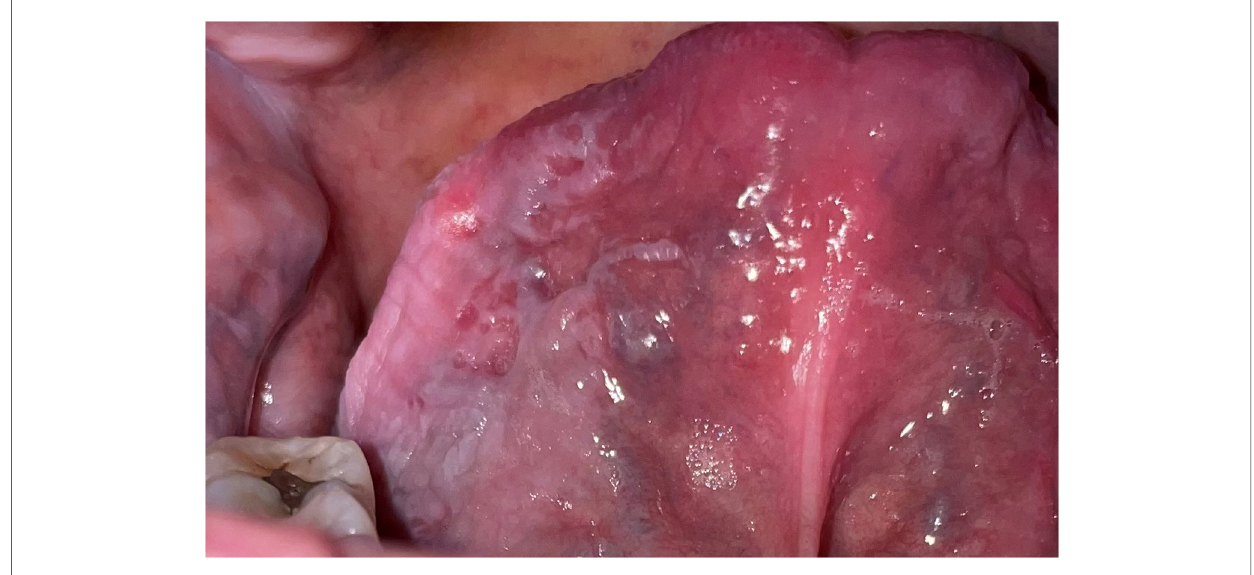
FIGURE 1 Extensive homogeneous leukoplakia involving the ventral tongue. Both its size and site are clinical indicators that this lesion is of clinical signi fi cance and has a greater potential to become malignant than a smaller leukoplakia in a different intra-oral site. It needs a base-line biopsy to enable correlation of the clinical fi ndings with the histology fi ndings before a treatment decision is